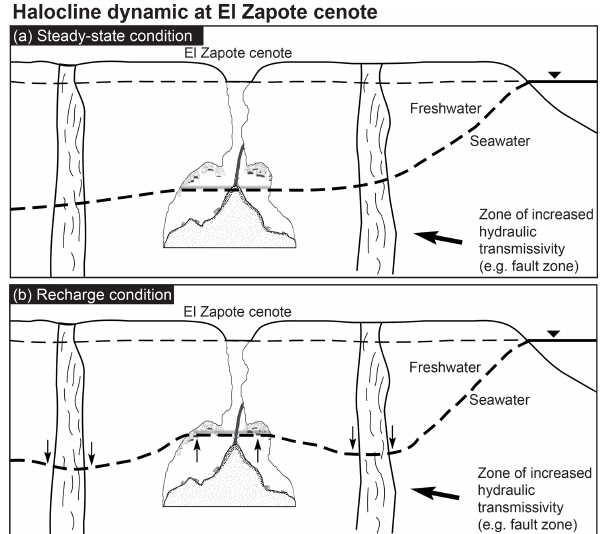
Figure 10. Sketch of dynamic halocline elevation within the Yu- catán karst aquifer. Halocline depth increases with increasing dis- tance from the coast in a steady-state condition (a) . Recharge events result in a lower halocline beneath areas of high vertical transmis- sivities and an elevated halocline in areas of low hydraulic transmis- sivity, e.g., El Zapote cenote (b)